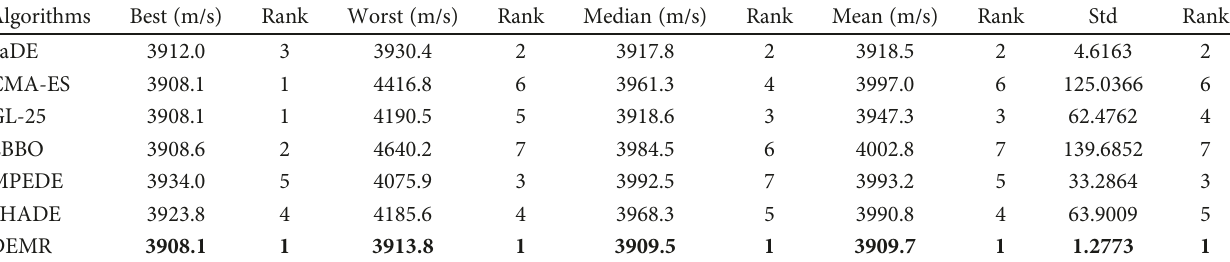
Table 5: Results for Earth-Moon low-energy transfer trajectory optimization in two-dimensional space with widened ranges.